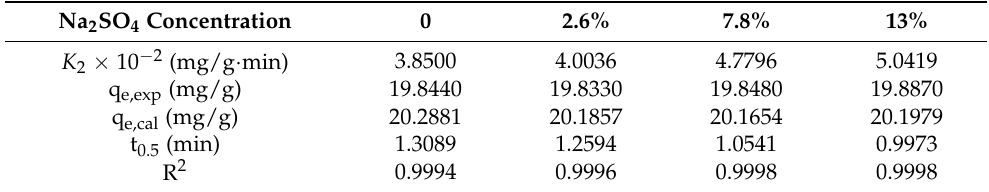
Figure 5. Pseudo-second-order kinetic fitting curve with different concentrations of sodium sulfate (( a ) 0%, ( b ) 2.6%, ( c ) 7.8%, ( d ) 13%) in D5 dyeing system. Table 3. Kinetic parameters of pseudo-second-order for adsorption of C.I. Reactive Red 120 with di ff erent concentrations of sodium sulfate in D5 dyeing system.